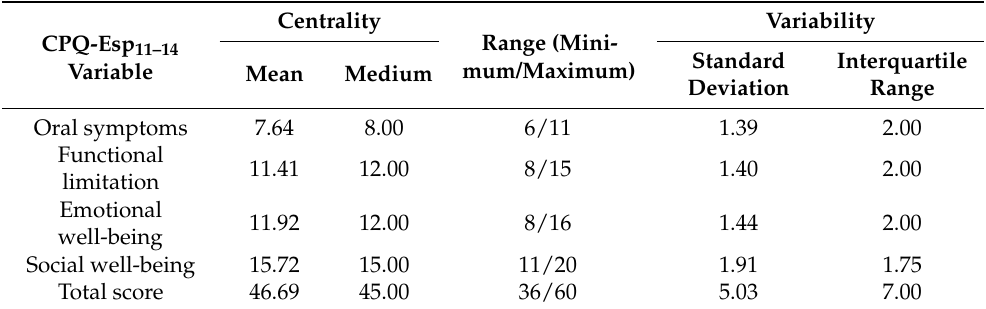
Table 1. Exploratory and descriptive analysis. Variables of the CPQ-Esp 11–14 questionnaire on OHRQoL ( n = 140).